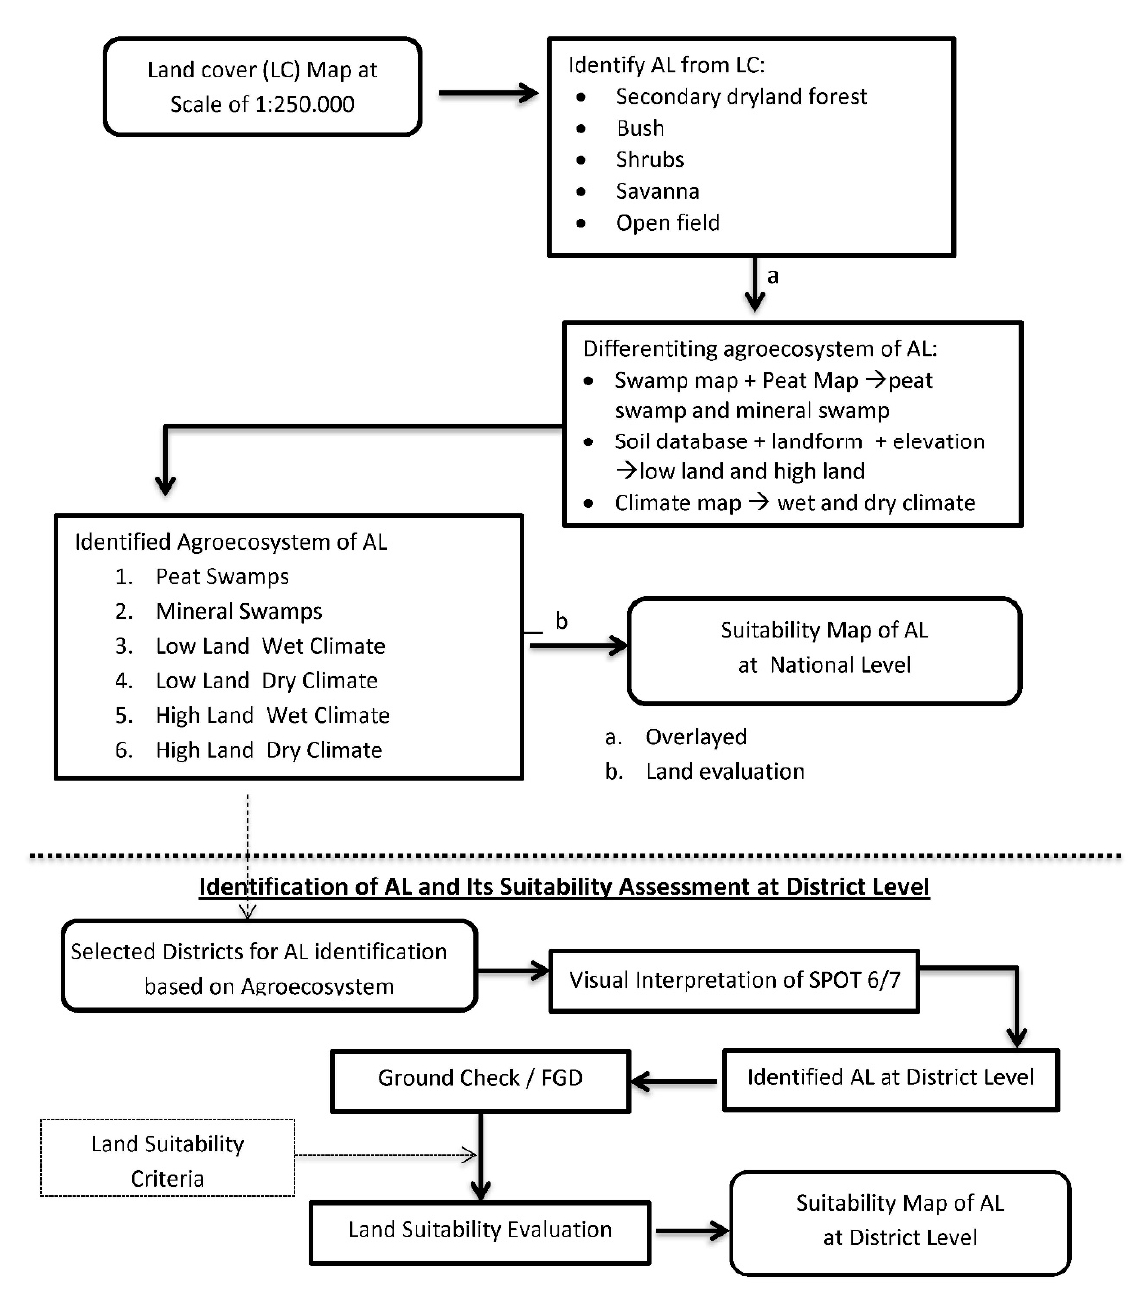
Figure 2. The procedure to identify AL at the national and district levels with the visual interpretation of SPOT 6/7.